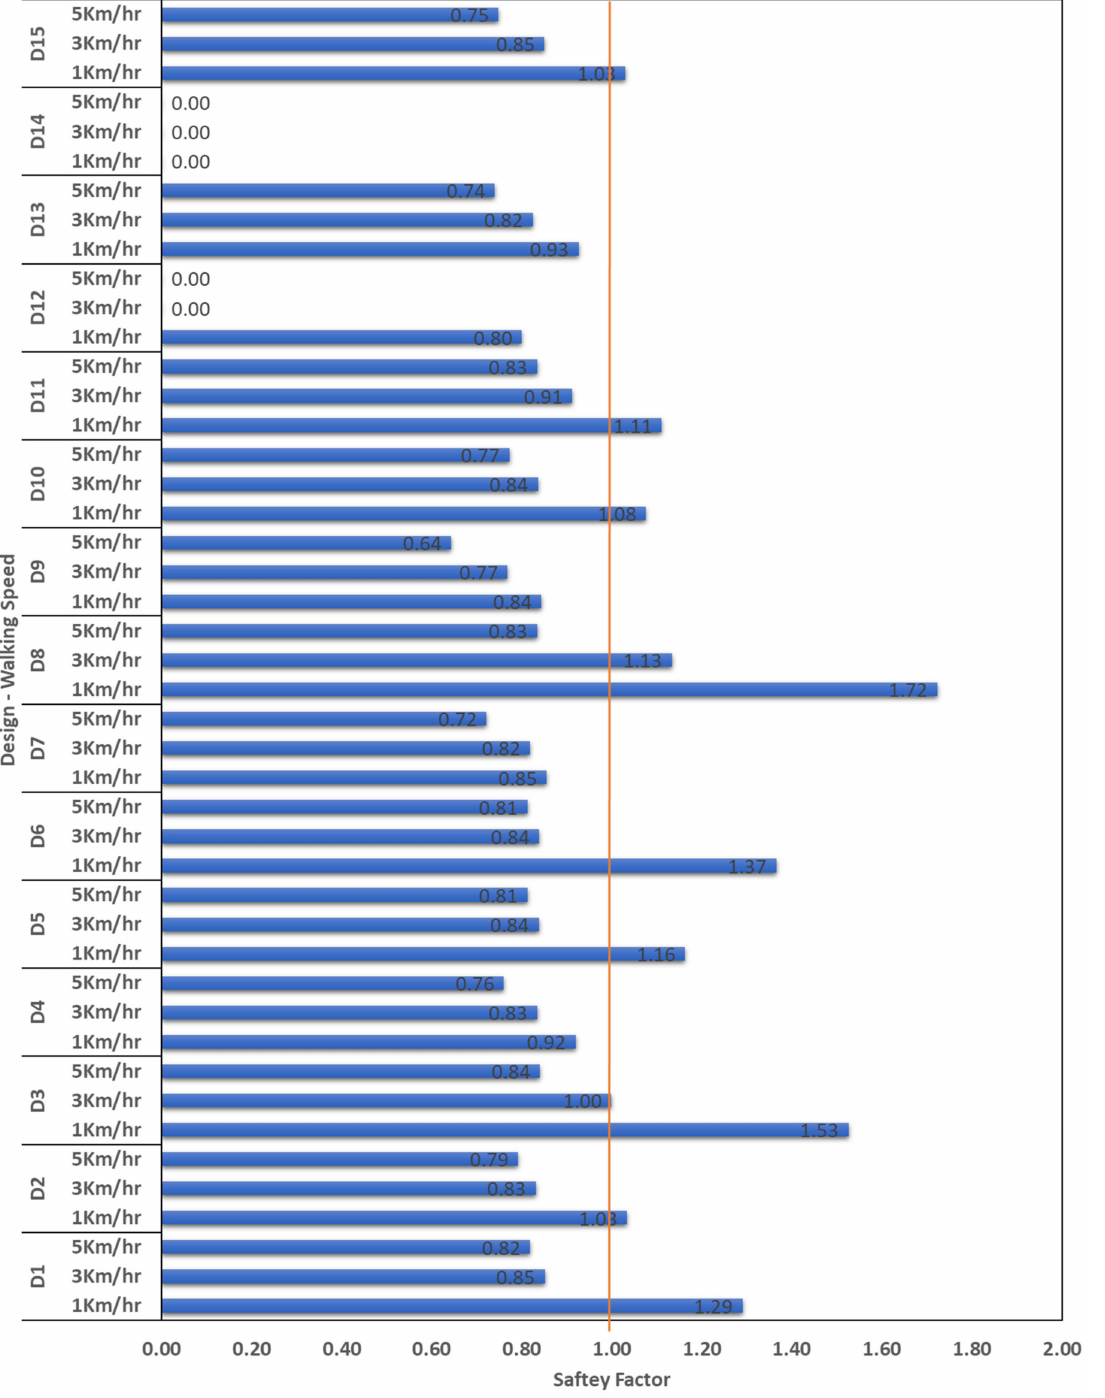
Figure 9. Soderberg factors of safety obtained for the designed stems under the three loading conditions. (0.0 values shown for D12 and 14 denotes that no results obtained as the FEA simulation does not converge due to the high volumetric porosity at the outer layer of the